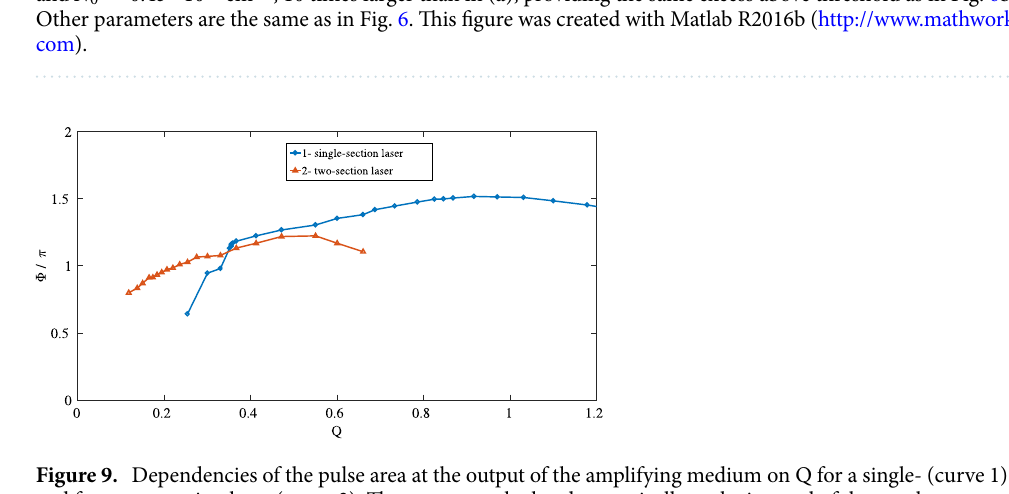
2 for N 0 2 ( t ) for T 2 = 25 ps